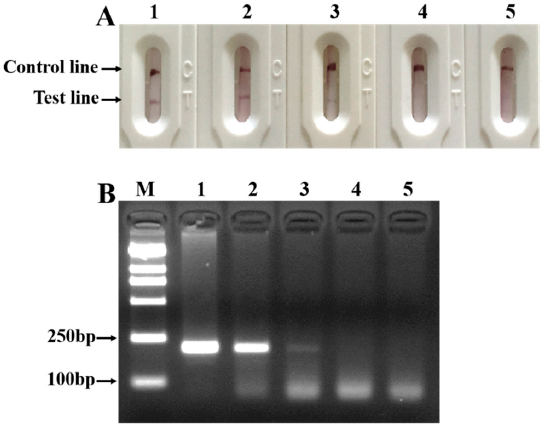
Figure 4. Comparison of the sensitivity of RPA-LFD and conventional PCR: ( A ) sensitivity of RPA- LFD, ( B ) sensitivity of conventional PCR. M, Marker 2000; lines 1–5 represent 50 ng, 10 ng, 0.1 ng, 0.01 ng, and blank control, respectively.